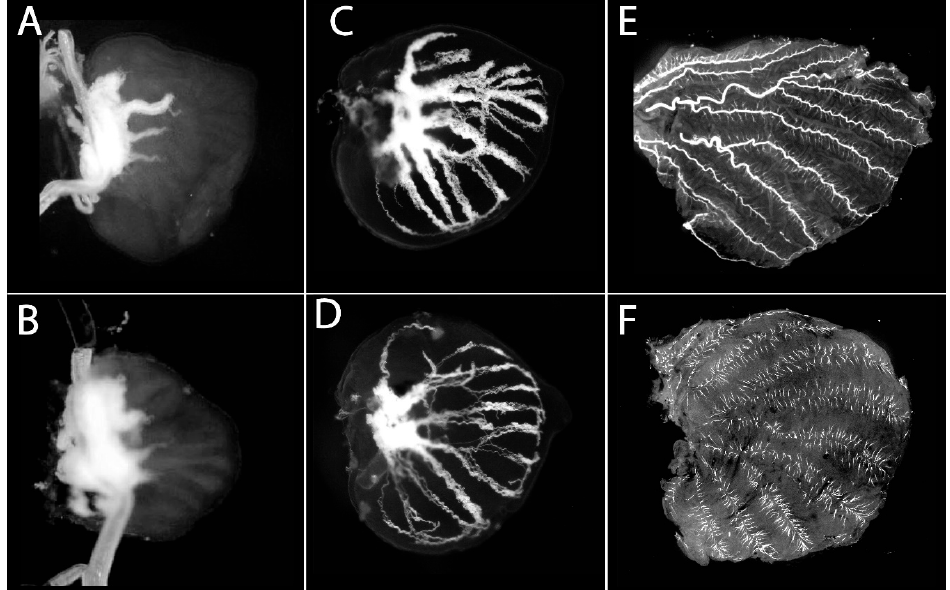
Figure 2. Larval and Pupal wings of Bicyclus anynana . ( A ) Early larval forewing showing the prominent white tissue that will differentiate into the trachea. Wings should be handled in this region during dissections; ( B ) Early larval hindwing; ( C ) Late larval forewing; ( D ) Late larval hindwing; ( E ) Pupal forewing; ( F ) Pupal hindwing.